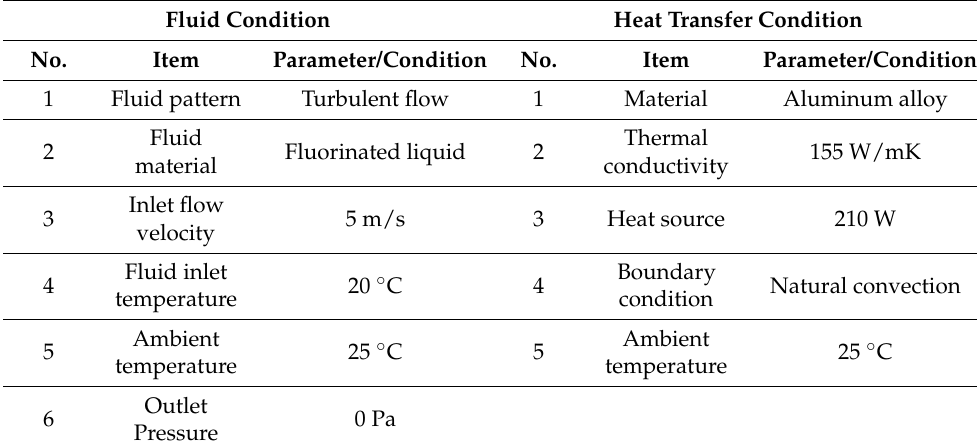
Figure 7. Three-dimensional cold plate heat source and fluid inlet/outlet position. Table 1. Simulation parameters of the heat dissipation of a three-dimensional cold